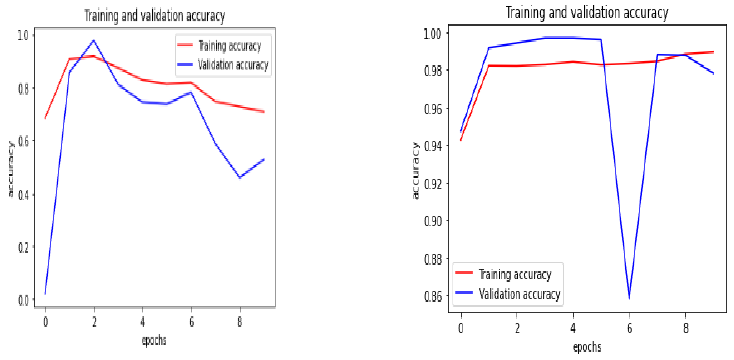
Figure 6. Training and validation accuracy of the existing and proposed systems.